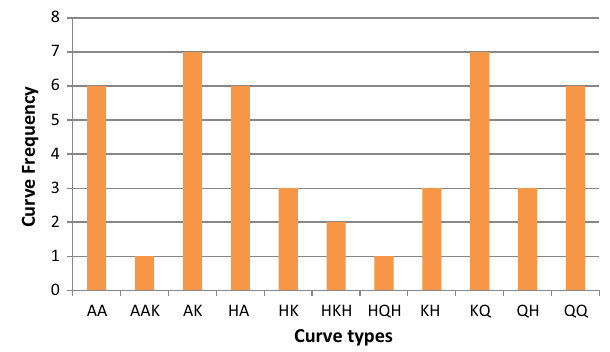
Fig. 3 Frequency distribution of curve